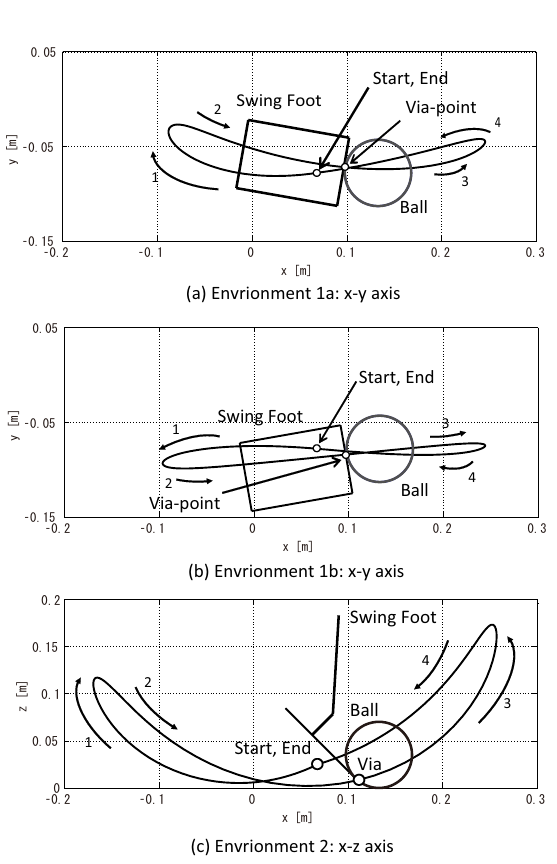
Figure 5. Planned position trajectory of the swing foot’s